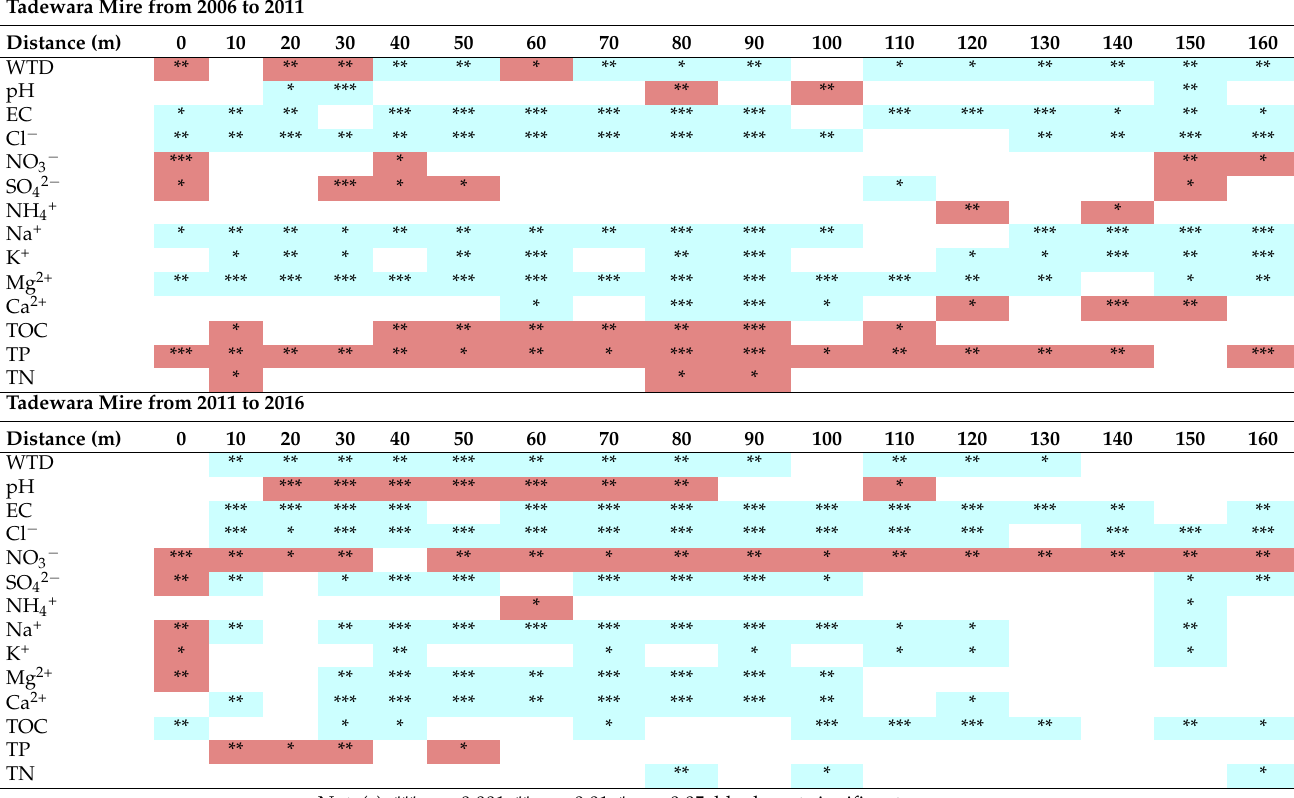
Table 4. Significance levels of regression of water environmental variables and elapsed days in Tadewara transect (TDW transect) from 2006 to 2011 and from 2011 to 2016. Red-colored cells mean significant positive slopes and blue-colored cells mean significant negative slopes.